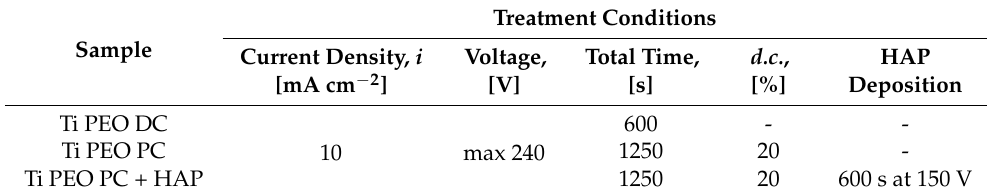
Table 1. PEO treatment conditions for obtaining the Ti-modified